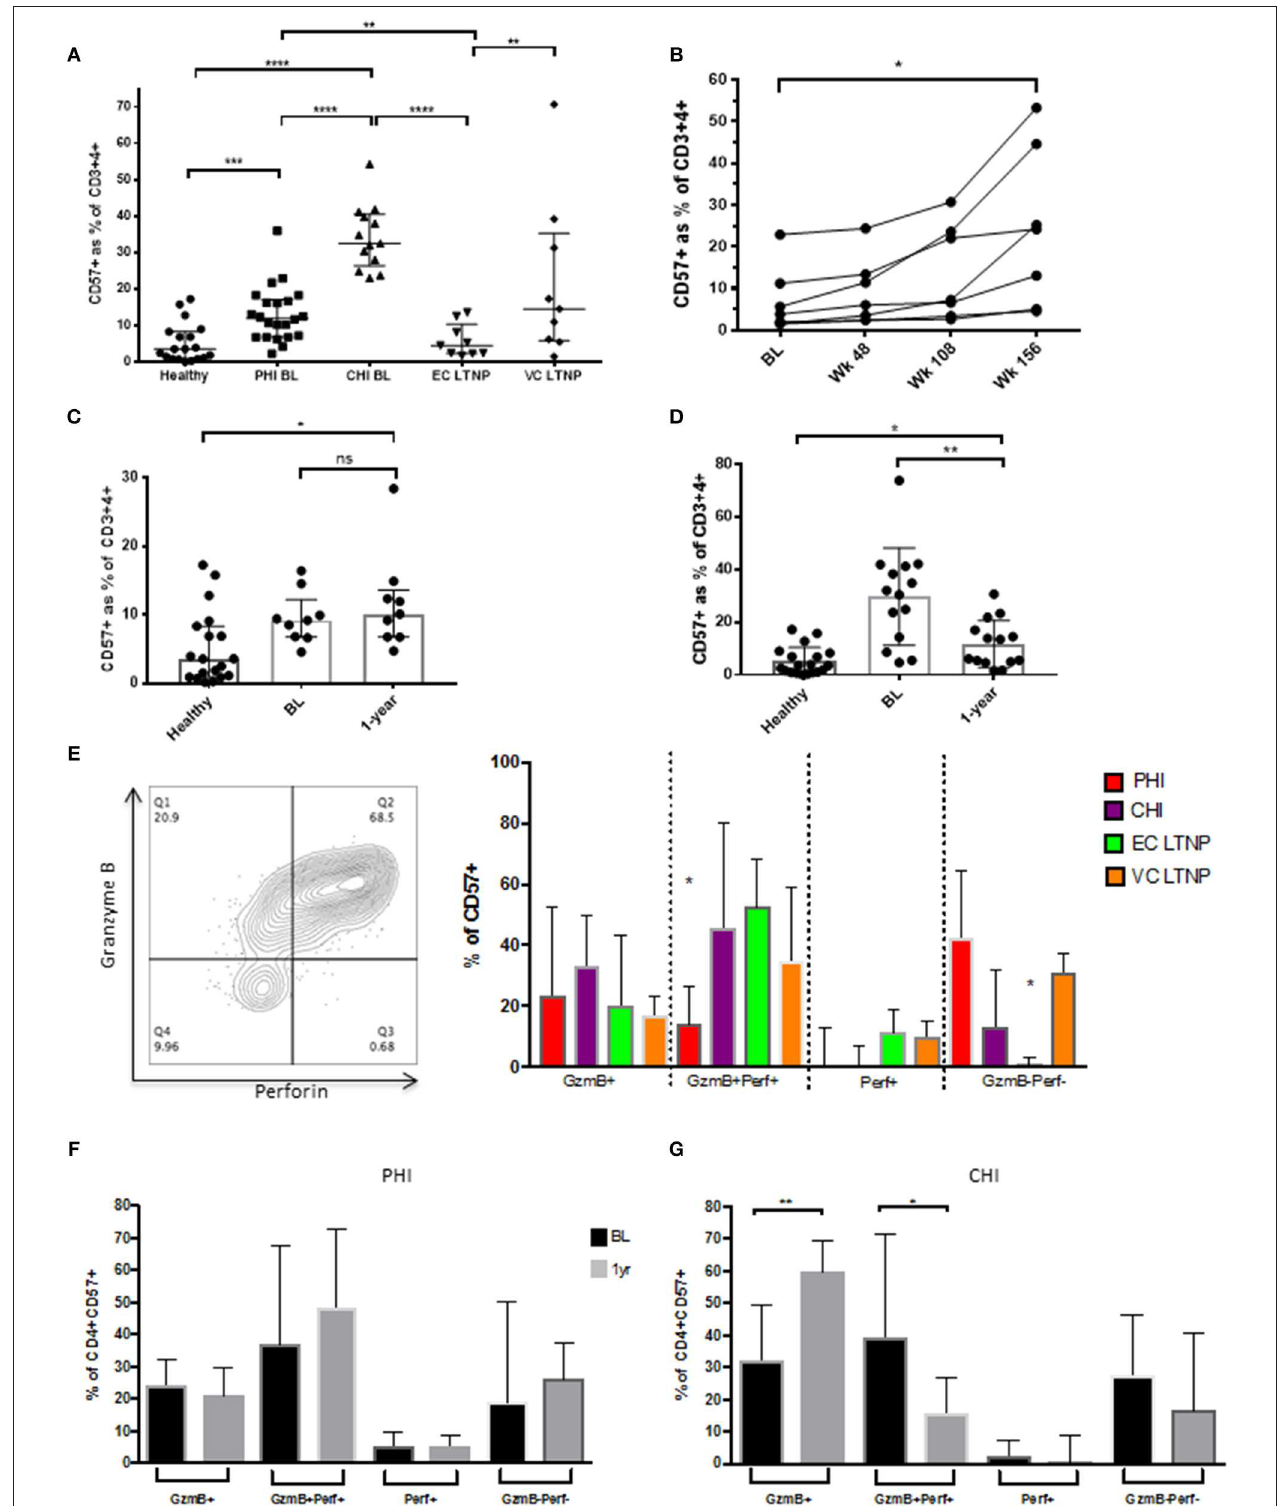
FIGURE 4 | Accumulation of CD57 + CD4 CTLs in HIV infection. (A) CD57 distribution between HIV infected cohorts. (B) Increased CD57 subset from baseline to week 156 in primary HIV (SPARTAC) standard of care arm ( n = 7). (C) No difference between CD57 frequencies at baseline and 1-year post-ART in PHI. (D) Decreased CD57 levels 1-year post-ART in CHI, with healthy donor as reference. (E) Granzyme B and Perforin expression in CD57 subset in differing stages of HIV infection. (F) No difference in GzmB and Perf expression PHI 1-year post-ART. (G) Increase of GzmB and decrease GzmB + Perf + post-ART in CHI. * p < 0.05, ** p < 0.01, *** p < 0.001, **** p < 0.0001.